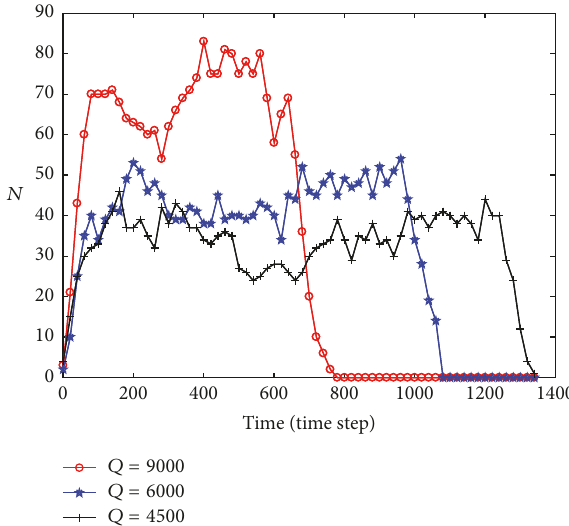
Figure 8: The relationships between 𝑁 and 𝑄 during the boarding process, where 𝑄 is the total inflow rate and 𝑁 is the number of passengers at the